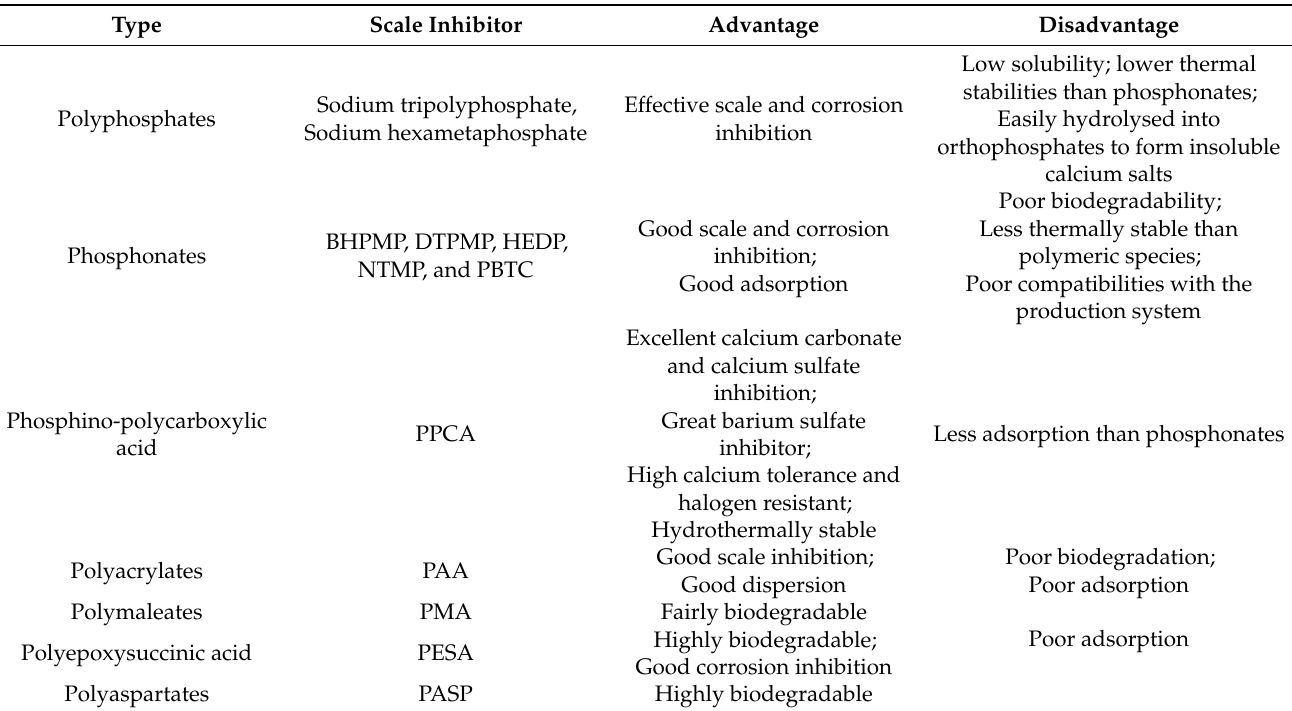
Table 1. Summary of the common scale